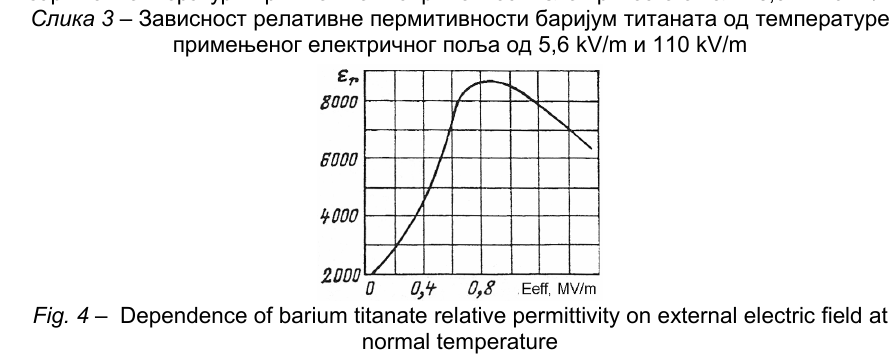
Fig. 4 – Dependence of barium titanate relative permittivity on external electric field at normal